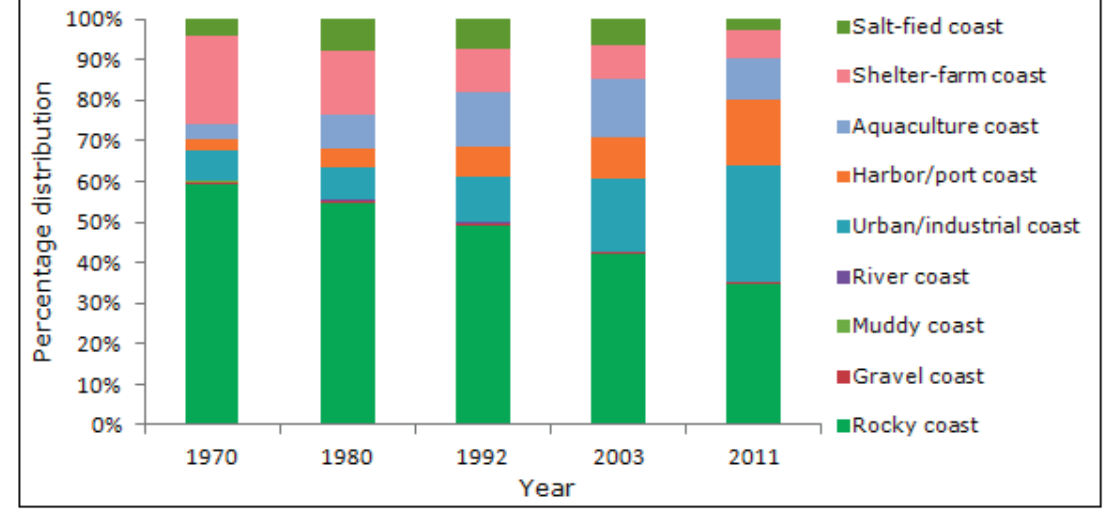
Figure 7. Percentage distribution of different coastal use types during